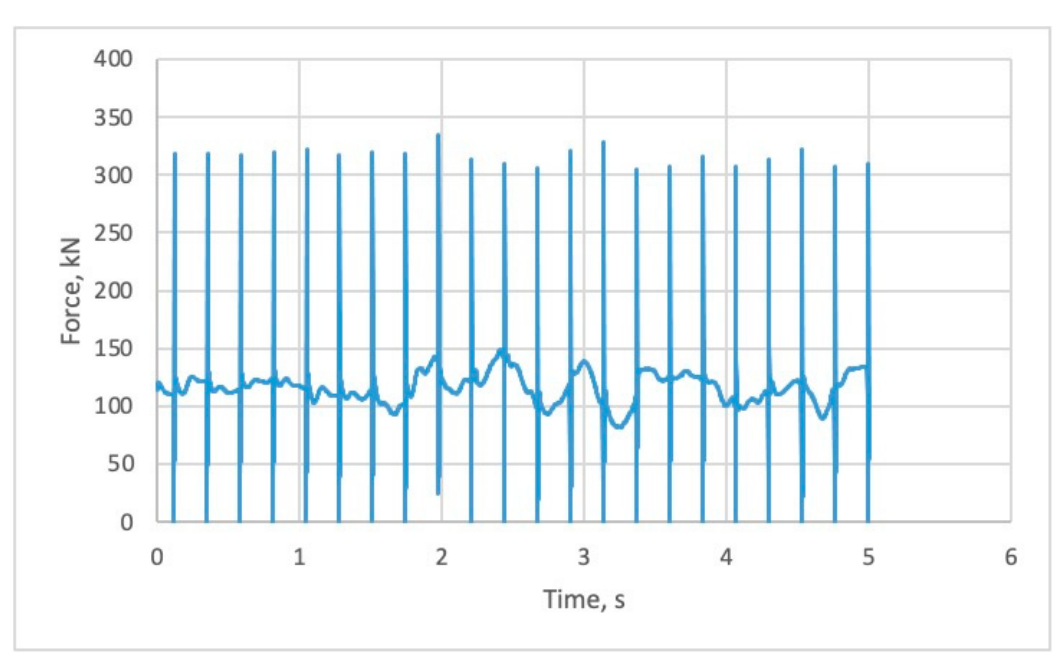
Figure 9. Calculated force values of the 69th wheelset.